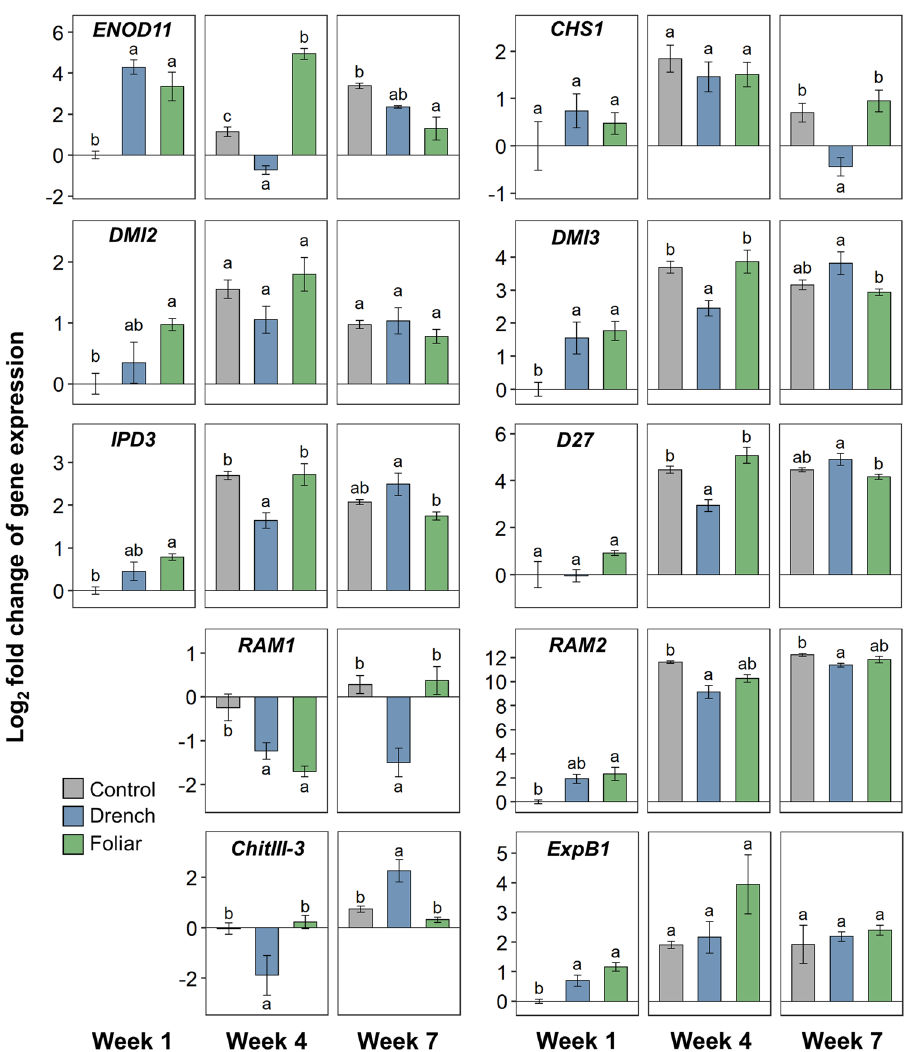
Figure 7. Expression of ENOD11 , CHS1 , DMI2 , DMI3 , IPD3 , D27 , RAM1 , RAM2 , ChitIII-3 , and ExpB1 in M. truncatula roots at week 1, 4 and 7 following inoculation with R. irregularis , as labelled. Values are the log 2 fold change, ΔΔC q , compared to the control at week 1, or week 4 when expression was below detectable levels at week 1. Letters indicate Tukey’s post-hoc test significance groups, α = 0.05, following analysis of variance per